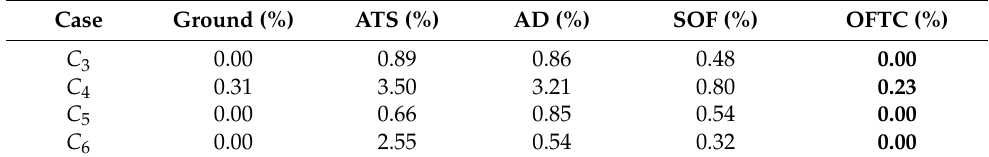
Table 3. Comparison of detection results of different methods under light pollution of a specific shape.